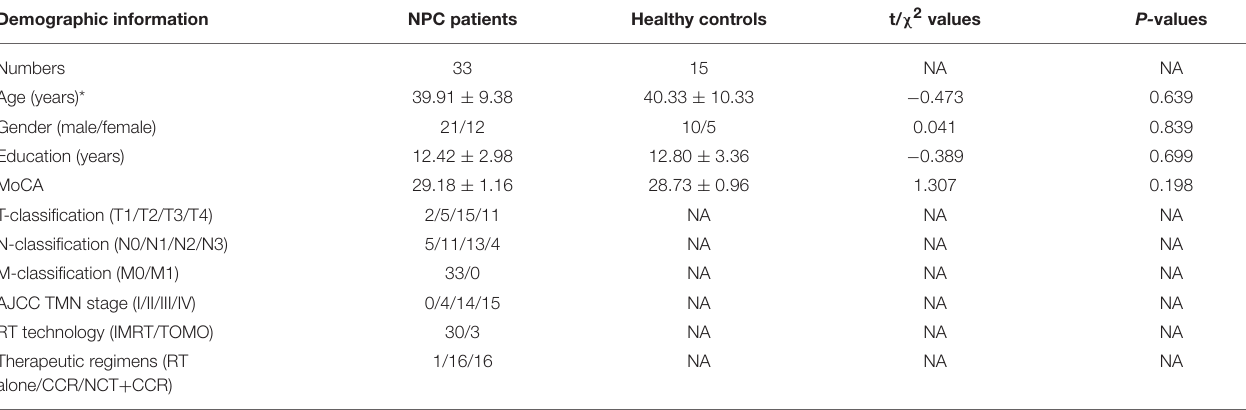
TABLE 2 | Demographic and clinical characteristics of the patients with nasopharyngeal carcinoma (NPC) and healthy controls at the baseline. Demographic